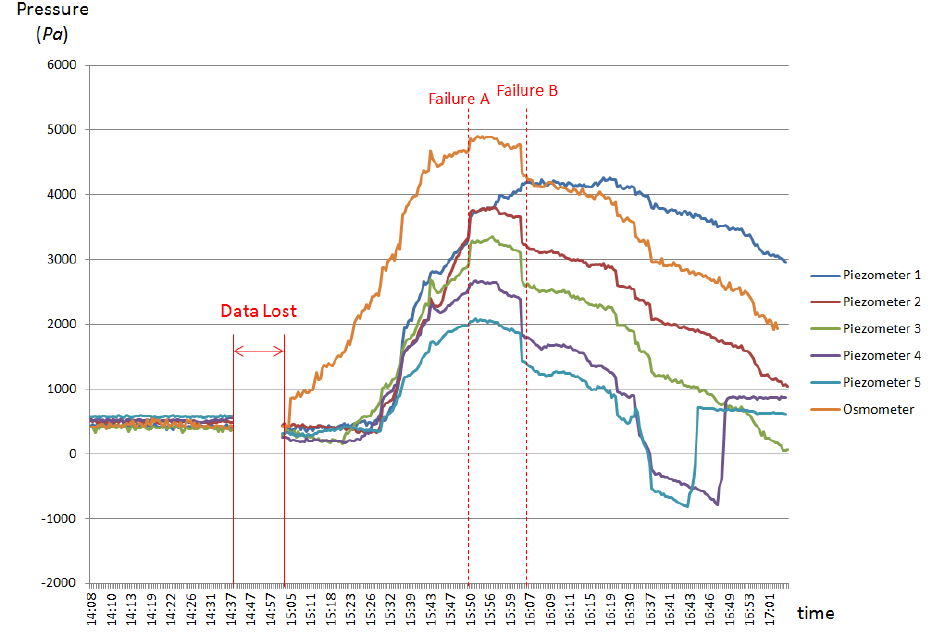
Figure 12. Monitoring data collected by the osmometer and the